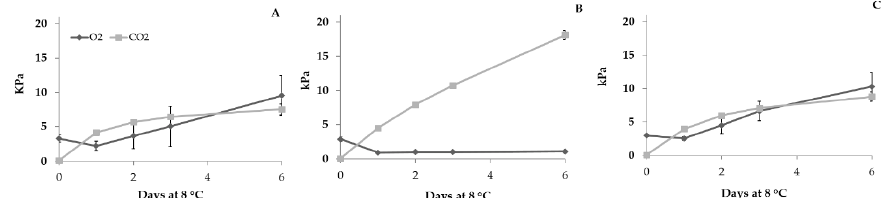
Figure 2. Changes in O 2 and CO 2 inside PP ( A ), PP/PA ( B ), PP/PA MP ( C ) fresh-cut iceberg lettuce bags. Data are mean ( n = 3) ± standard deviation.